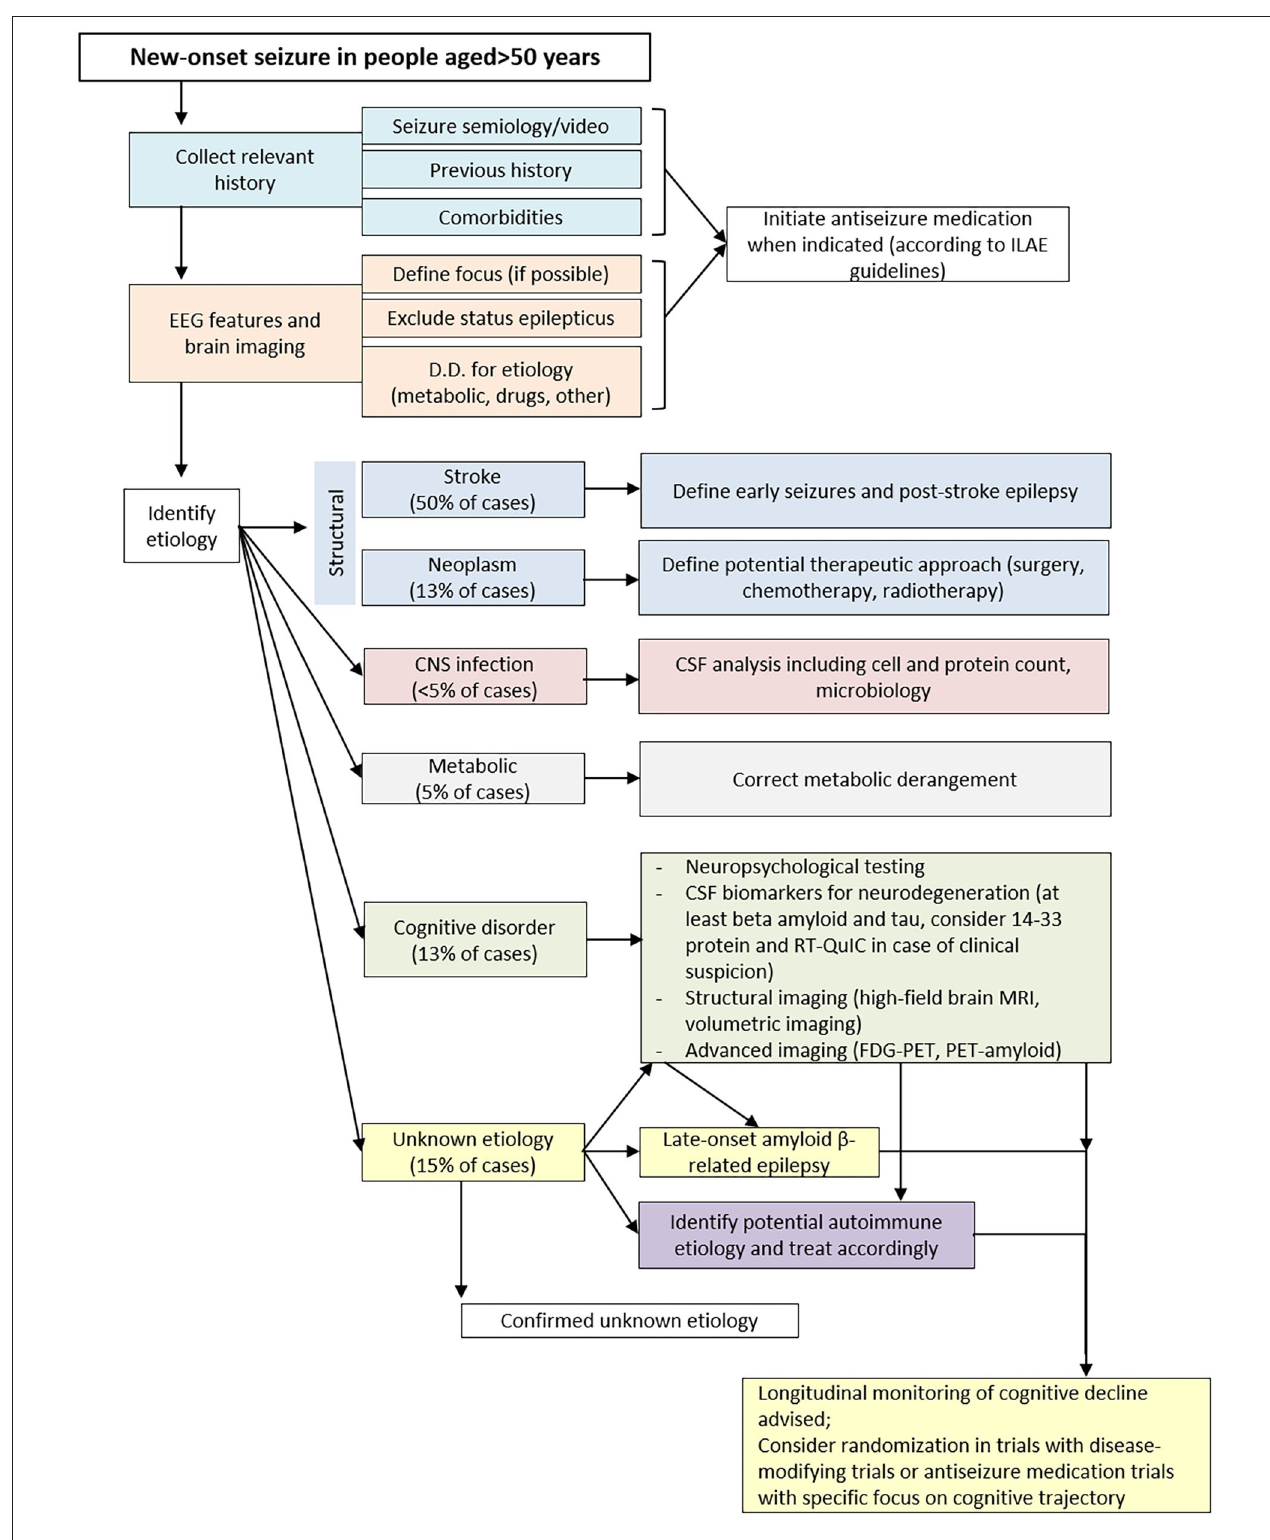
FIGURE 1 | Flow-chart for the characterization of patients with LOE.